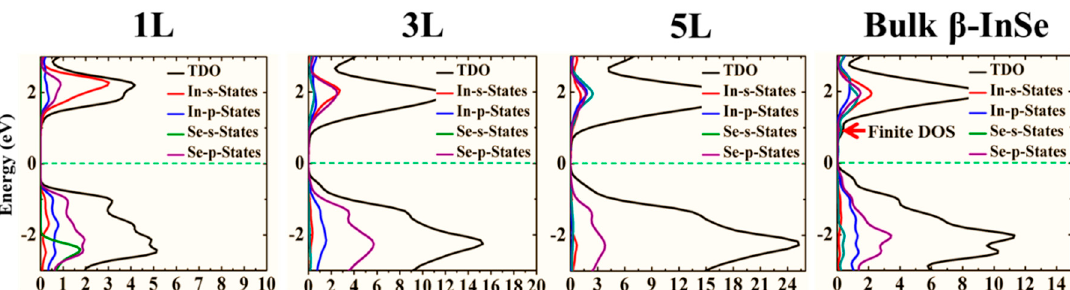
Figure 3. Calculated total density of states (TDOS) and partial density of states (PDOS) of β -InSe monolayer (1 L), few-layer (3 L and 5 L) and bulk β -InSe. The green horizontal dashed line represents Fermi energy level set to be 0 eV.